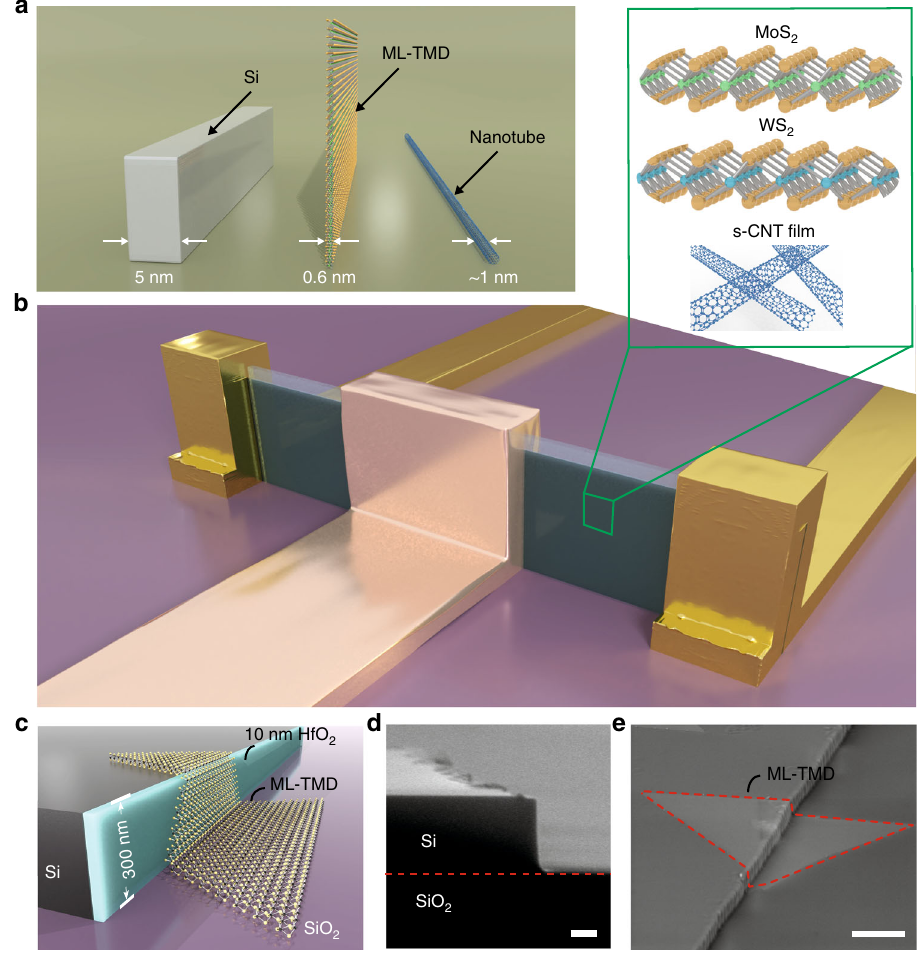
(cid:1) 0.6 nm. a Demonstration of the ML-TMD fi n as compared to etched Si- fi n and nanotubes in their typical dimensions. Fig. 1 The ML-FinFET with W fin b Schematic picture of the ML-FinFET presented in this work. Inset in b shows the several options for depositing the fi n materials in this structure. c Schematic of a monolayer MoS 2 crystal growing over a 300 nm height Si step, with the side wall coated by HfO 2 . d Scanning electron micrograph (SEM) image of the as-fabricated 300 nm Si step. e SEM morphology of a typical monolayered MoS crystal growing over the 300 nm height step, while the dash 2 red lines highlight the outline of the crystal. Scale bars in d , e are 100 nm and 1 µ m,